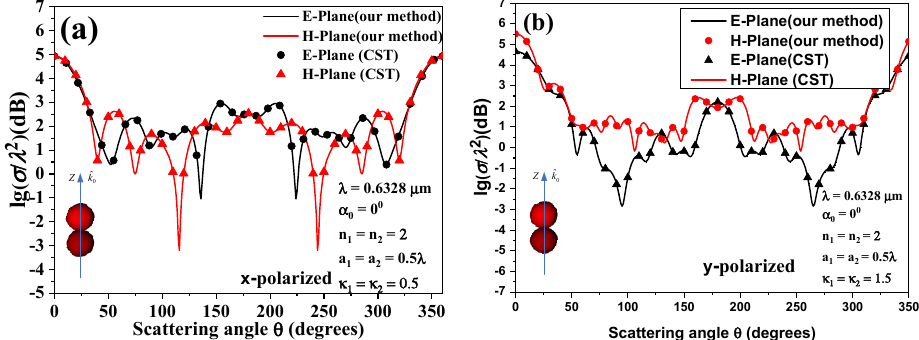
Figure 3. Contrast of our simulations of angular distributions of normalized RCS with that of CST software: ( a ) x -polarized; ( b ) y -polarized.